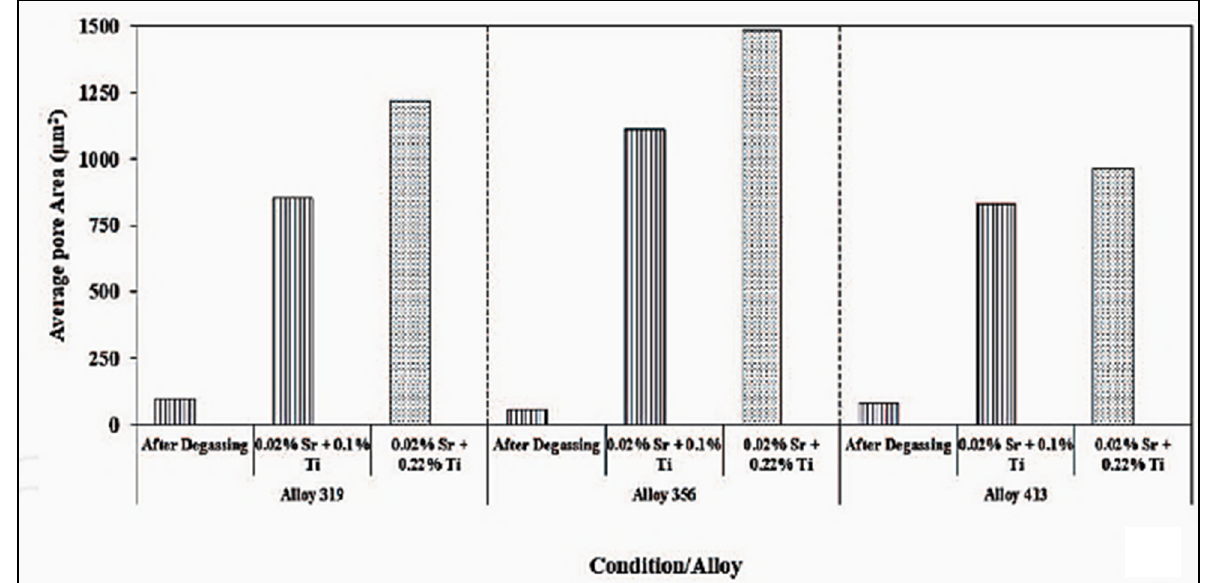
Figure 13. Effect of total amount of added Sr and grain refiner on the average pore size in three Al–Si based alloys.